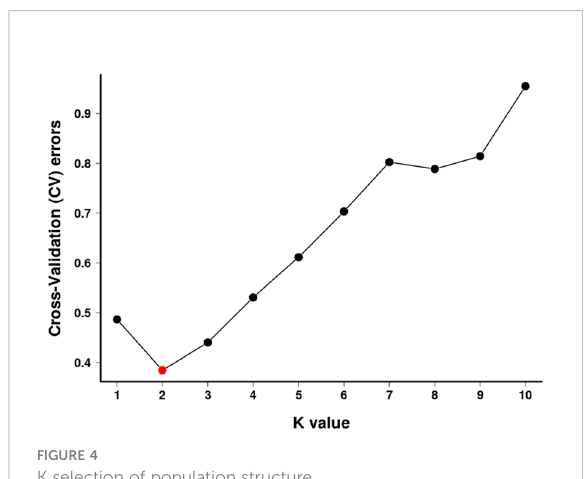
FIGURE 4 K selection of population